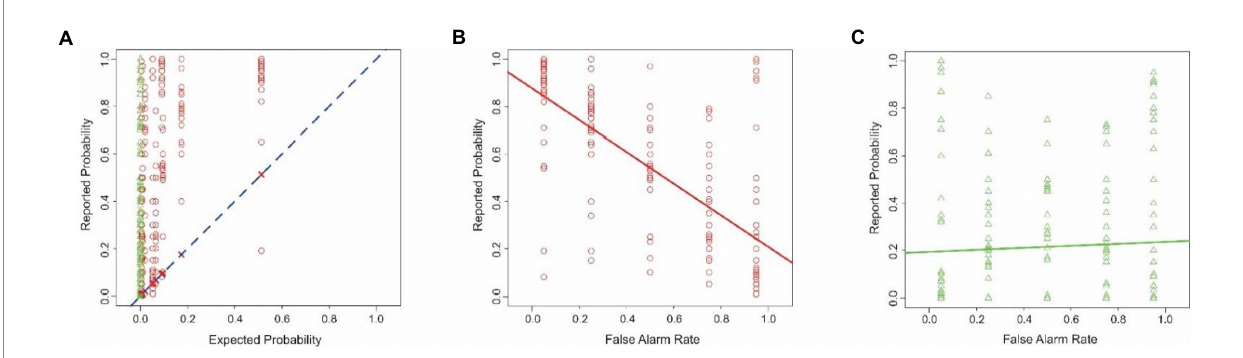
FIGURE 3 Estimation errors in Experiment 2. The data are plotted according to the conventions used in Figure 1. (A) Probability of drunk driving estimated by the subjects plotted as a function of the corresponding theoretically expected probability. (B,C) Interaction between the false alarm rate and the binary decision of the breathalyzer. See text for details.